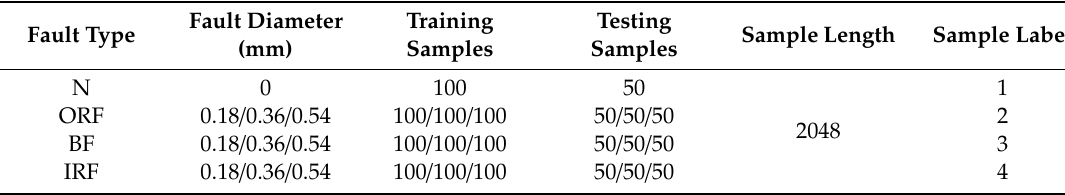
Table 2. Training and testing samples of the bearing dataset in Experiment 1.